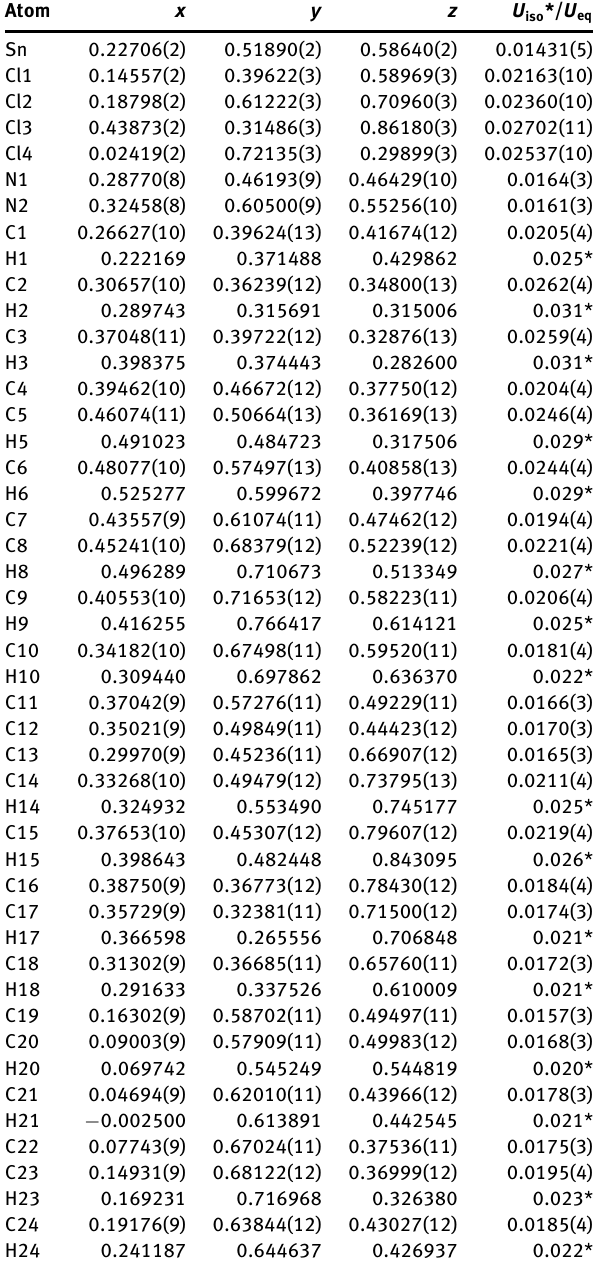
Table 2: Fractional atomic coordinates and isotropic or equivalent isotropic displacement parameters (Å 2